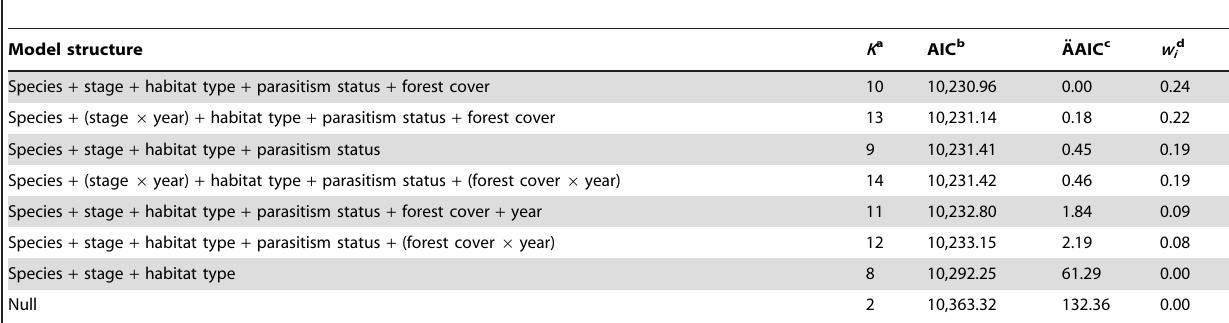
Table 2. Model selection results from analysis of temporal trends of nest survival for Indigo Buntings, Acadian Flycatchers, and Northern Cardinals in Missouri, USA,